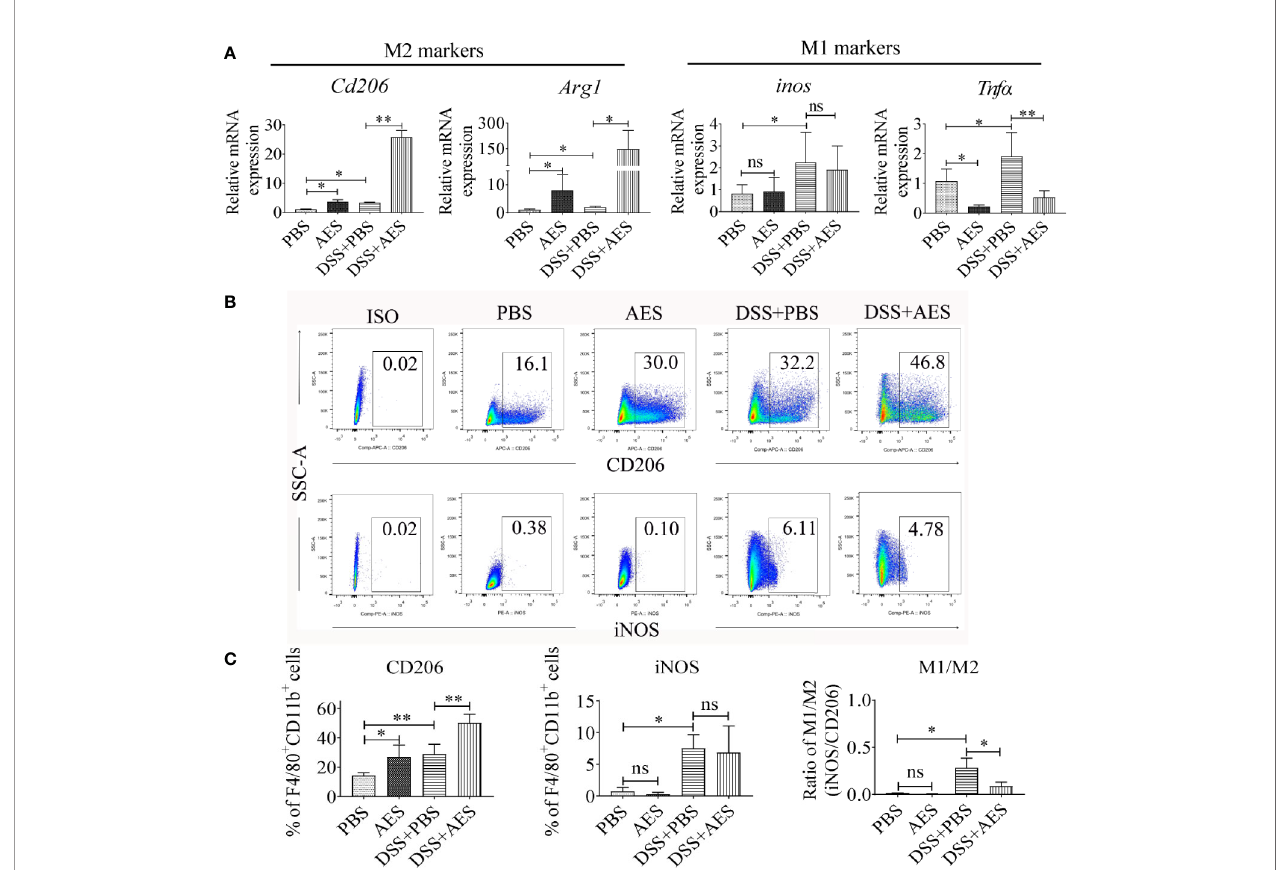
FIGURE 2 | Treatment with AES stimulated M2 macrophage polarization in mice with DSS-induced colitis. Each group of mice (n=6) was treated with DSS, AES, DSS+AES, and PBS, respectively. (A) The mRNA expression of M2 ( Cd206, Arg1 ) and M1 ( inos, Tnf a ) associated genes in peritoneal macrophages collected from each treated group were measured by qRT-PCR (n=6). The relative expression level was compared with PBS control group as a baseline. (B) Peritoneal macrophages collected from each mouse group were analyzed by fl ow cytometry. The representative side scatter area (SSC-A) plots are shown for CD206 (M2) and iNOS (M1) labeling (n=6 per group). (C) The percentage of CD206 (M2) and iNOS (M1) expressed macrophages (F4/80 + , CD11b + ) in each group (n=6) (left, middle) and their M1/M2 ratio in each mouse group (n=6) (right). Experiments were repeated in triplicate. Data are expressed as means ± SEM; * P < 0.05, ** P < 0.01; ns = not signi fi